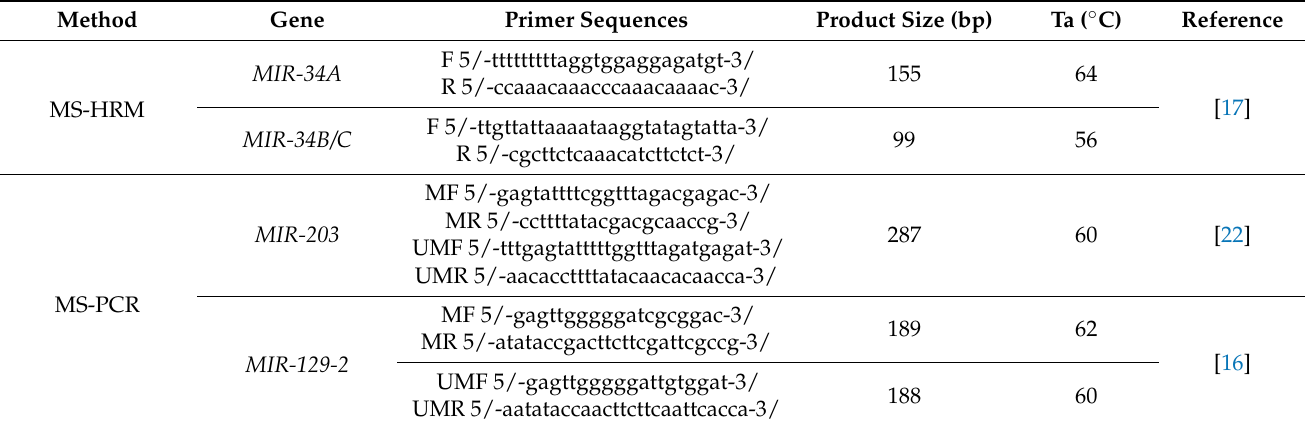
Figure 3. The results of the study of the methylation status of the MIR-34B/C ( a ) and MIR-34A ( b ) genes by the methyl-sensitive analysis of melting curves in clinical samples. Tm—melting point, UM-allele—unmethylated allele, Met-allele—methylated allele. Table 6. Primer sequences and reaction